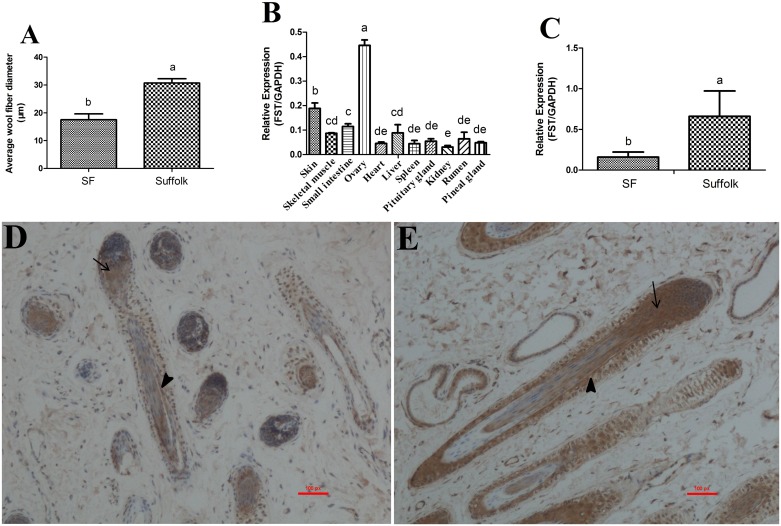
Ovine FST gene expression.(A) The average wool fiber diameter of SF (n = 3) and Suffolk (n = 3) sheep. In a row with different superscripts differ significantly (P < 0.05). (B) The FST gene expression in various tissues of the SF sheep (n = 3). The housekeeping gene GAPDH was used as an internal control for real-time RT-PCR analysis. In a row with different superscripts differ significantly (P < 0.05). (C) The FST gene expression levels in the body side skin between SF (n = 8) and Suffolk (n = 8). The housekeeping gene GAPDH was used as an internal control for real-time RT-PCR analysis. In a row with different superscripts differ significantly (P < 0.05). (D) Immunohistochemical localization of FST in SF sheep skin (n = 3). (E) Immunohistochemical localization of FST in Suffolk sheep skin (n = 3). The inner root sheath, arrowhead; matrix, arrow.